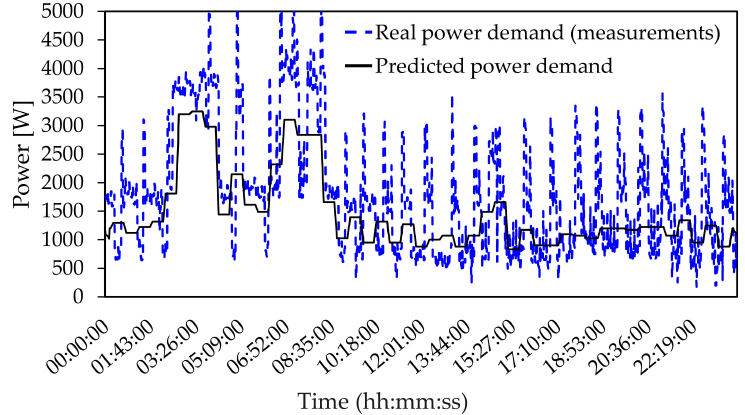
Figure 15. Example of an electricity consumption prediction for 1 day (house No. 1, 3 inhabitants, 130 m 2 , electric heating, sampling period equal to 1